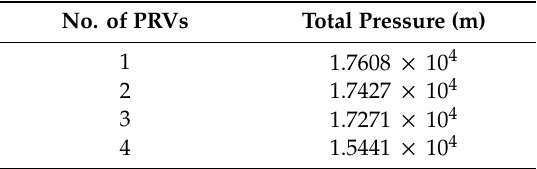
Table 3. Total pressure with PRVs for the WDS benchmark with three demand patterns.